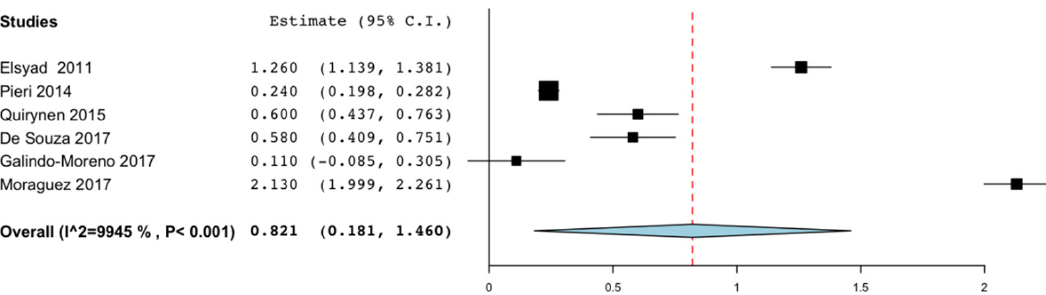
Figure 3. Peri-implant marginal bone loss at 36 months.